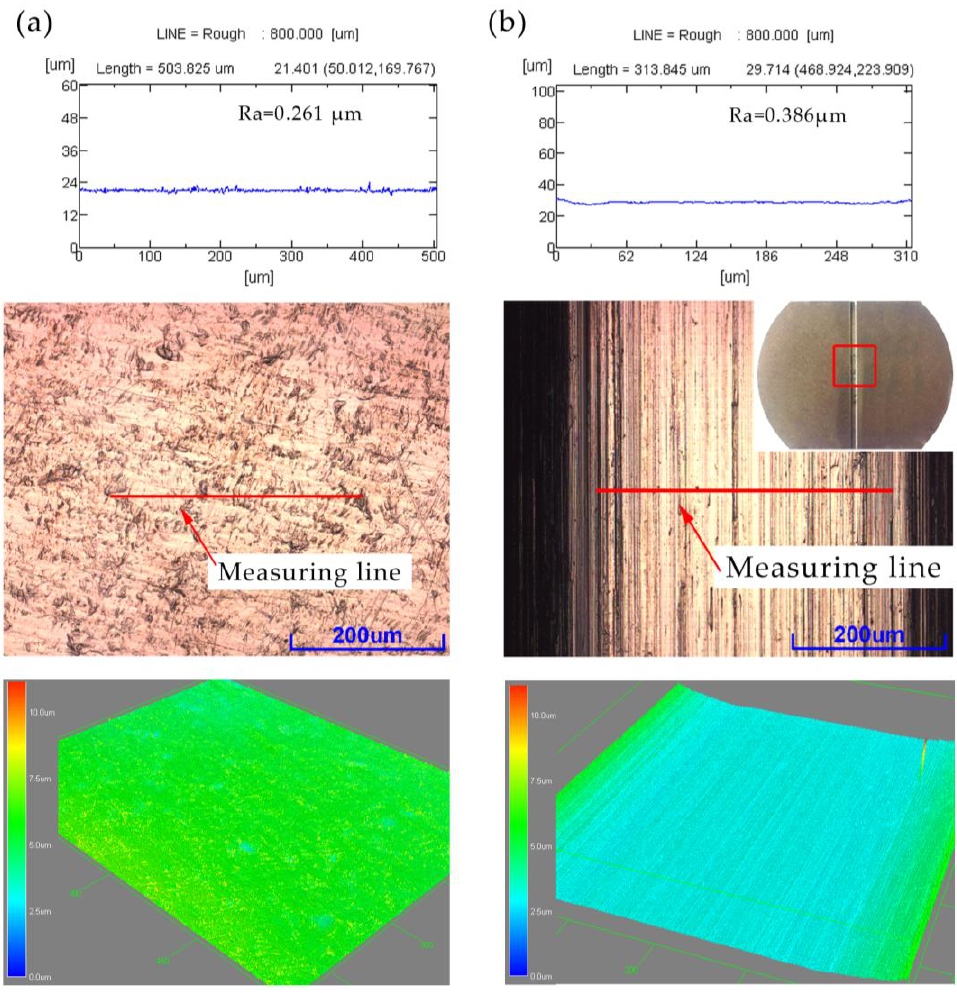
Figure 6. The surface roughness: of ( a ) raw material nickel and ( b ) rigid die.